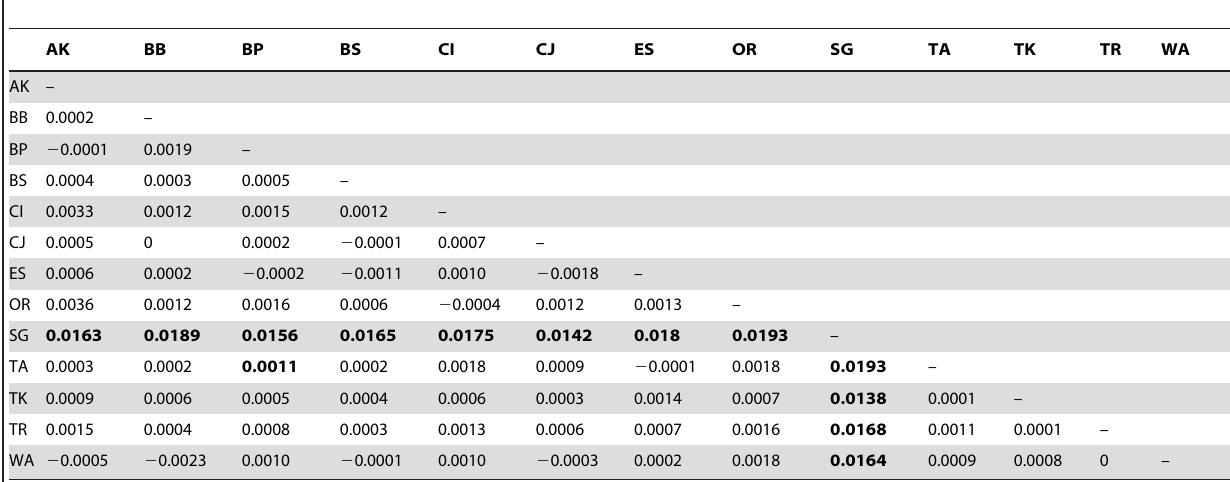
Table 2. Pairwise F ST